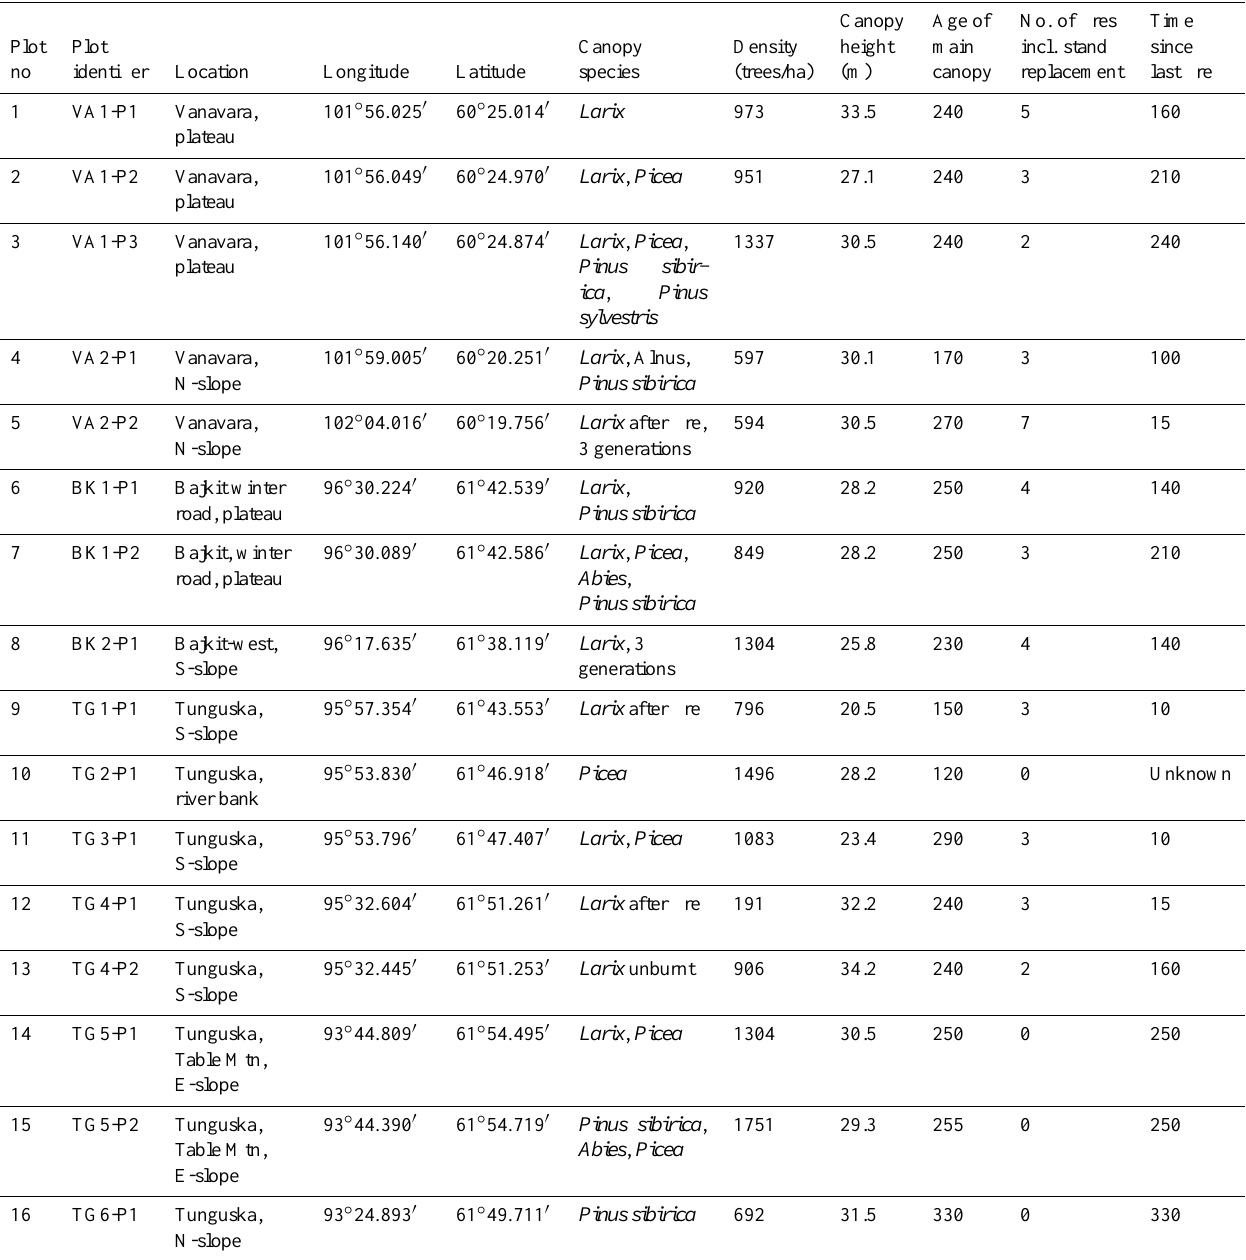
Table 2. Stand locations, canopy species, stand density and canopy height of the study plots. Picea is a Picea obovata , and Abies is Abies sibirica